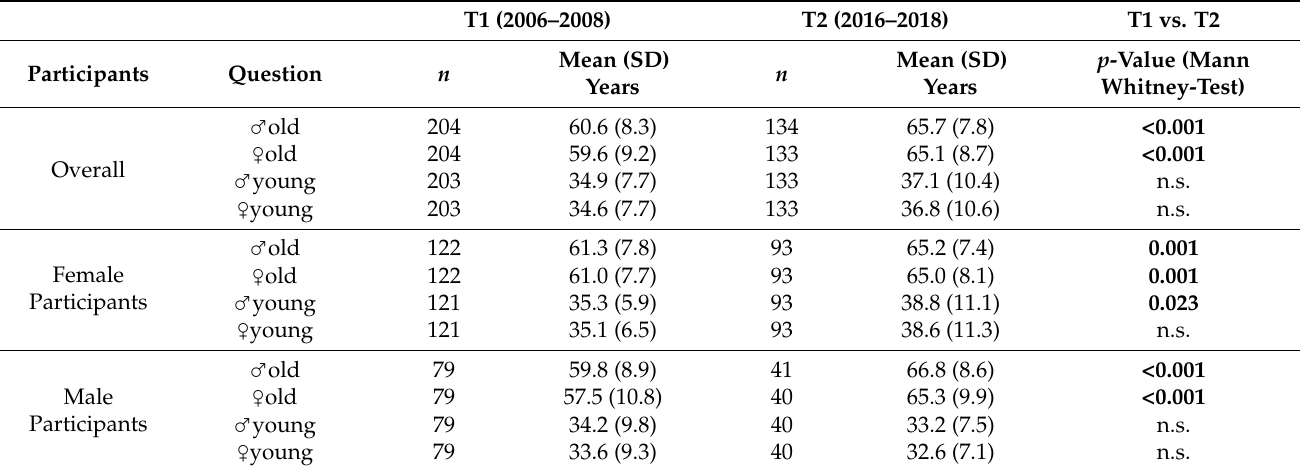
Table 1. Thresholds for being old and young as issued by undergraduate dental students in two cohorts (2006–2008 (T1), 2016– 2018 (T2)); significant differences between T1 and T2 are presented in bold; missing data due to incomplete